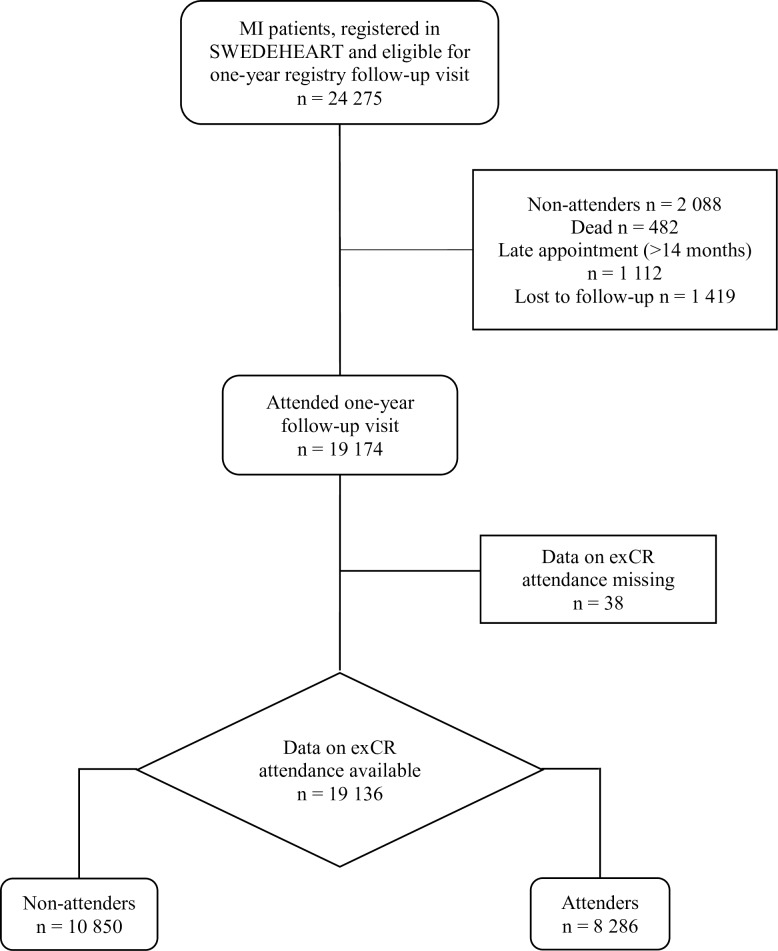
Flow chart of the patients included in this study.The figure shows the number of patients post MI registered in the SWEDEHEART registry in 2011–2013 who attended one-year follow-up thereafter and where data on exCR attendance was available.